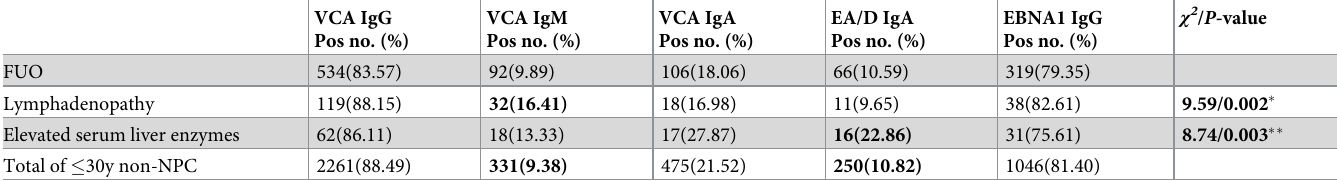
Table 3. Comparison of anti-EBV antibodies in (cid:20) 30 years old non-nasopharyngeal carcinoma patients with various symptoms at the PUMC Hospital, Beijing, 2013–2017. VCA IgG Pos no. (%)